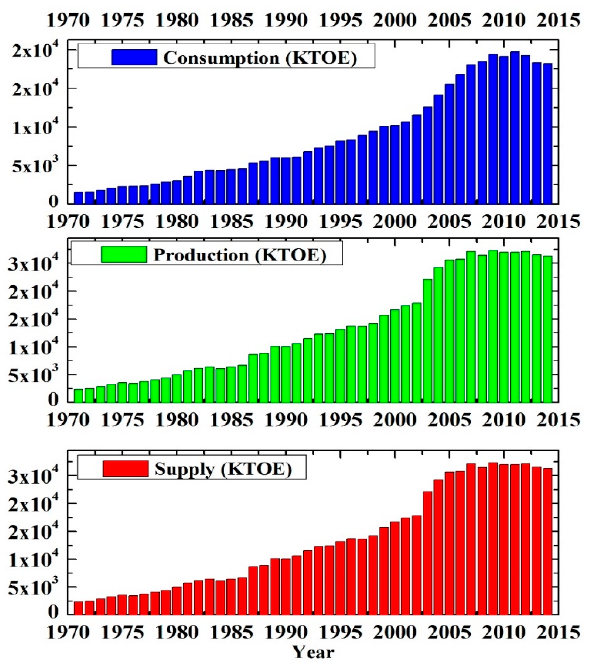
Figure 12. Historical supply, production, and consumption of natural gas (ktoe).